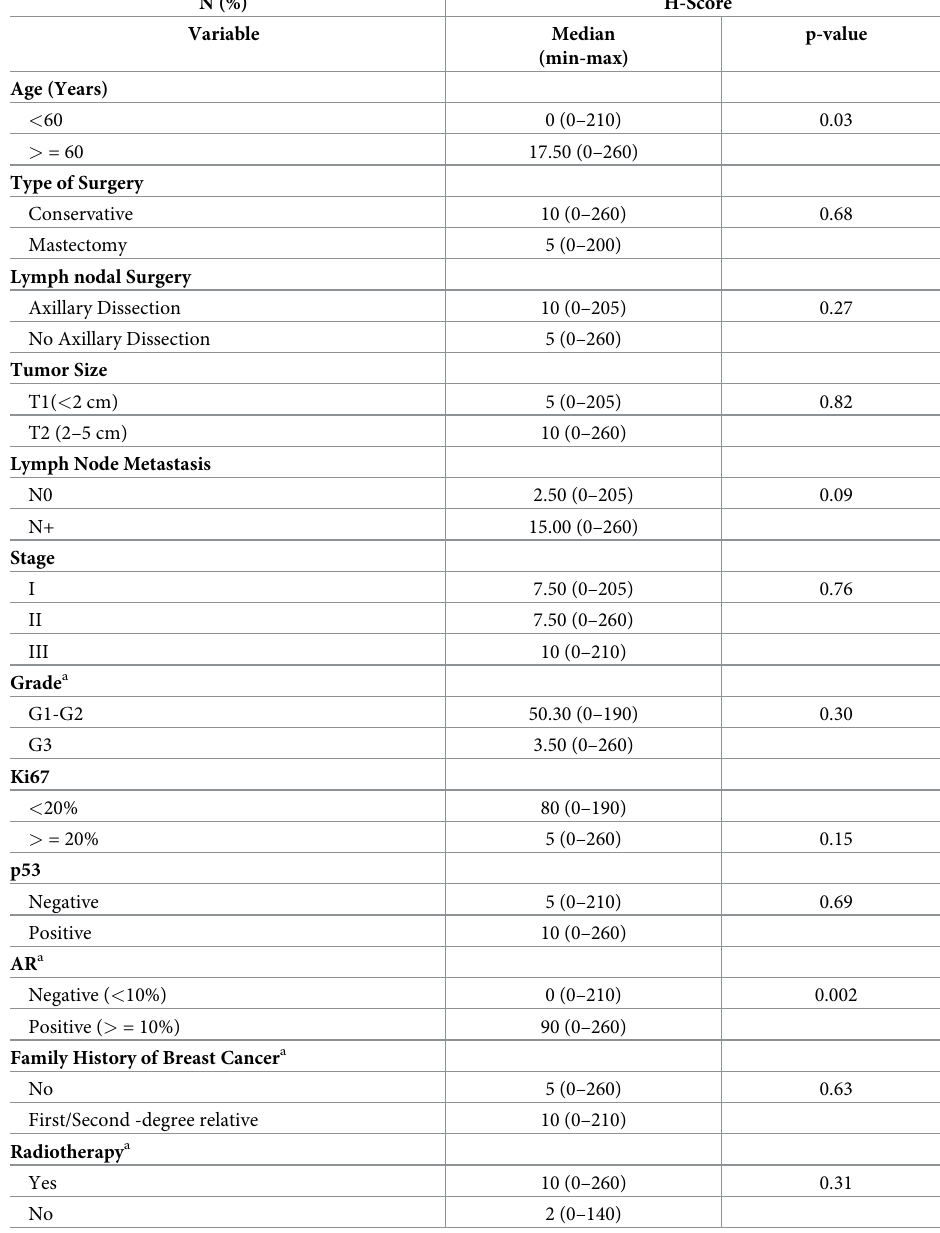
Table 2. H score values in relation to baseline